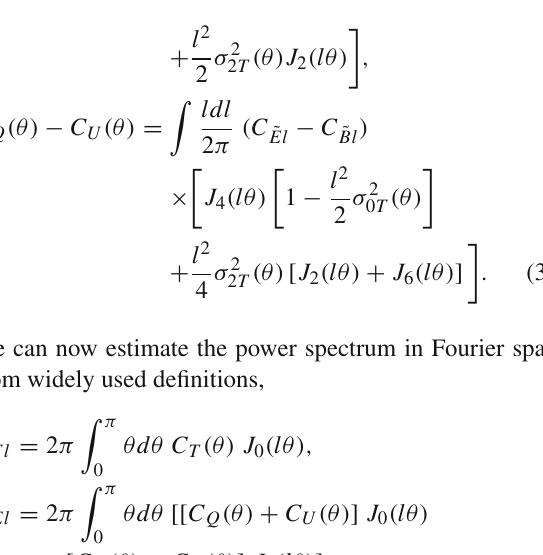
Fig. 3 Left: fractional contribution to E- and T-mode due to lensing including the contribution from the long wavelength mode (1). Right: the fractional change in power spectrum due to the long wavelength mode in comparison to standard